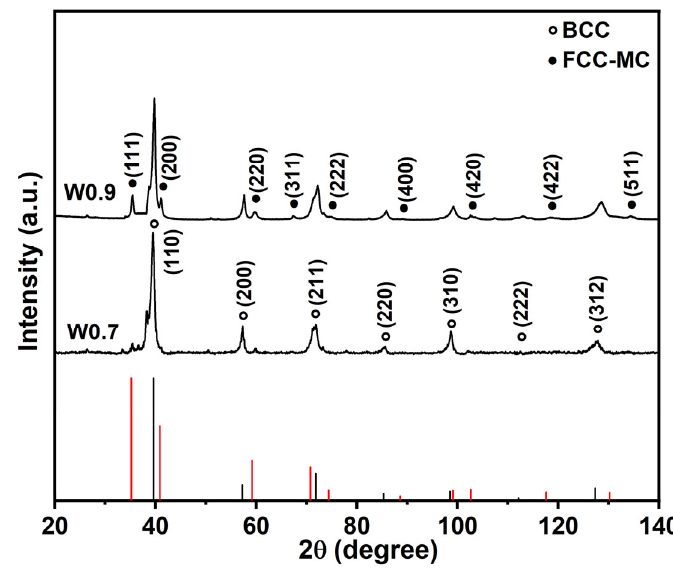
Figure 1. XRD patterns of MoNbTa(WC) x composites.